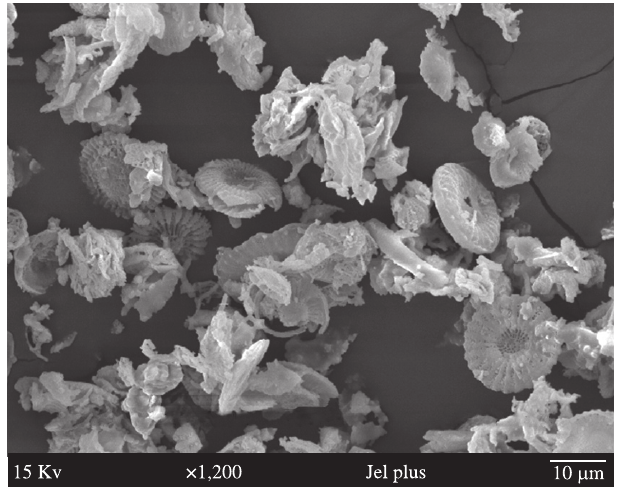
Figure 2. Typical scanning electron photomicrograph of Jeltrate Plus inorganic fraction. Just as Jeltrate, there are several particles with different shapes and sizes, predominating a helical form with various